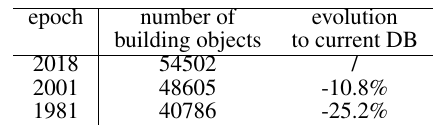
Table 1. Statistics about the evolution of the building objects in the DB